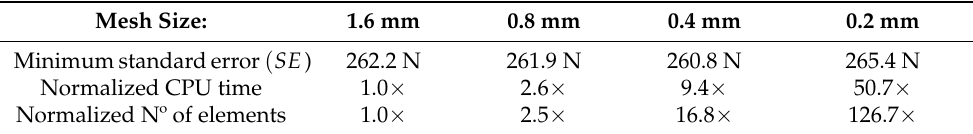
Table 8. Mesh sensitivity—minimum standard error of load–elongation curve, CPU time, and the number of